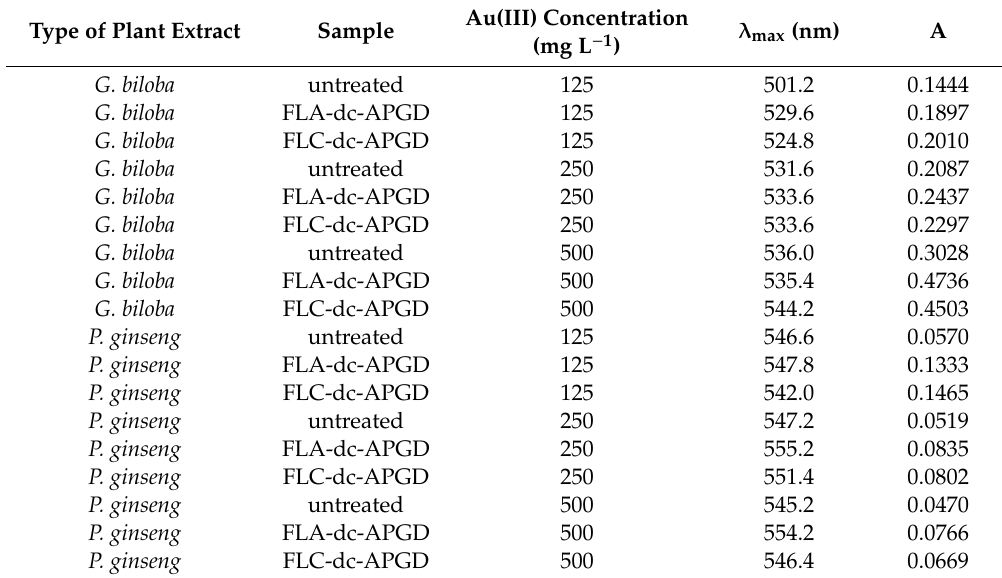
Table 1. Optical properties of AuNPs and absorbance (A) values at the maximum wavelength ( λ max ) of their localized surface plasmon resonance (LSPR) absorption